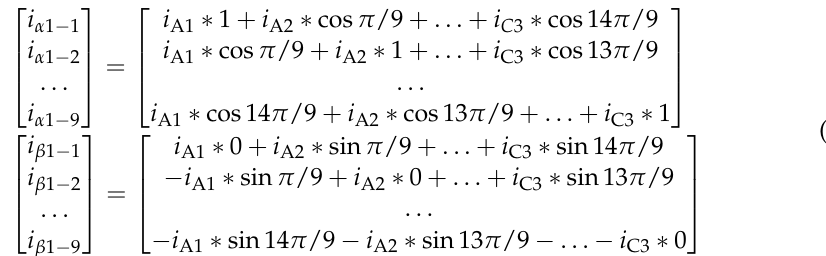
S t ep 4 Figure 5. Block diagram of proposed method.